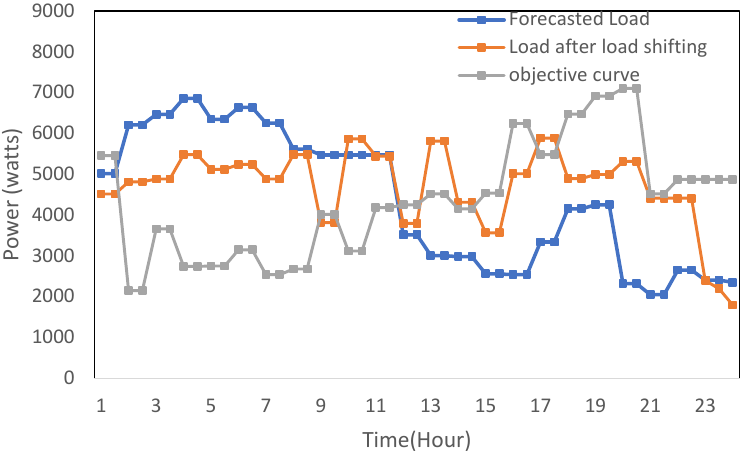
Figure 13. DSM results of industrial load under summer conditions.